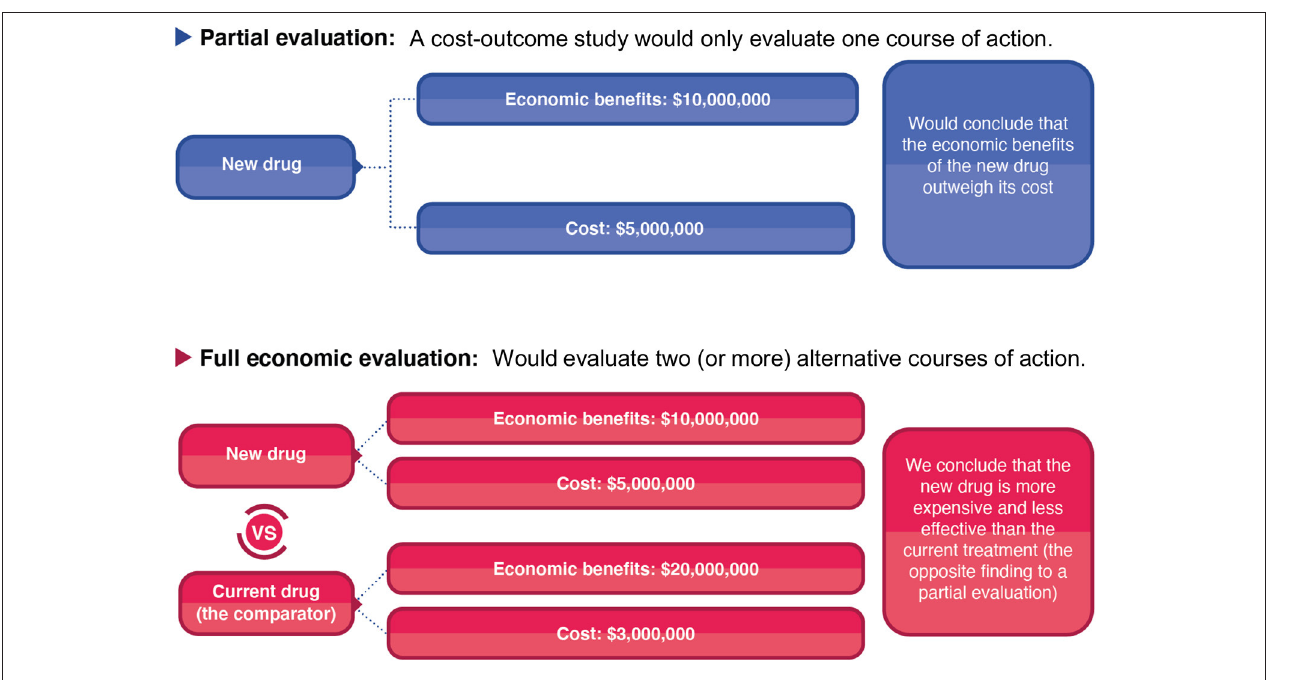
FIGURE 2 | A hypothetical comparison of the difference between a partial evaluation and full economic